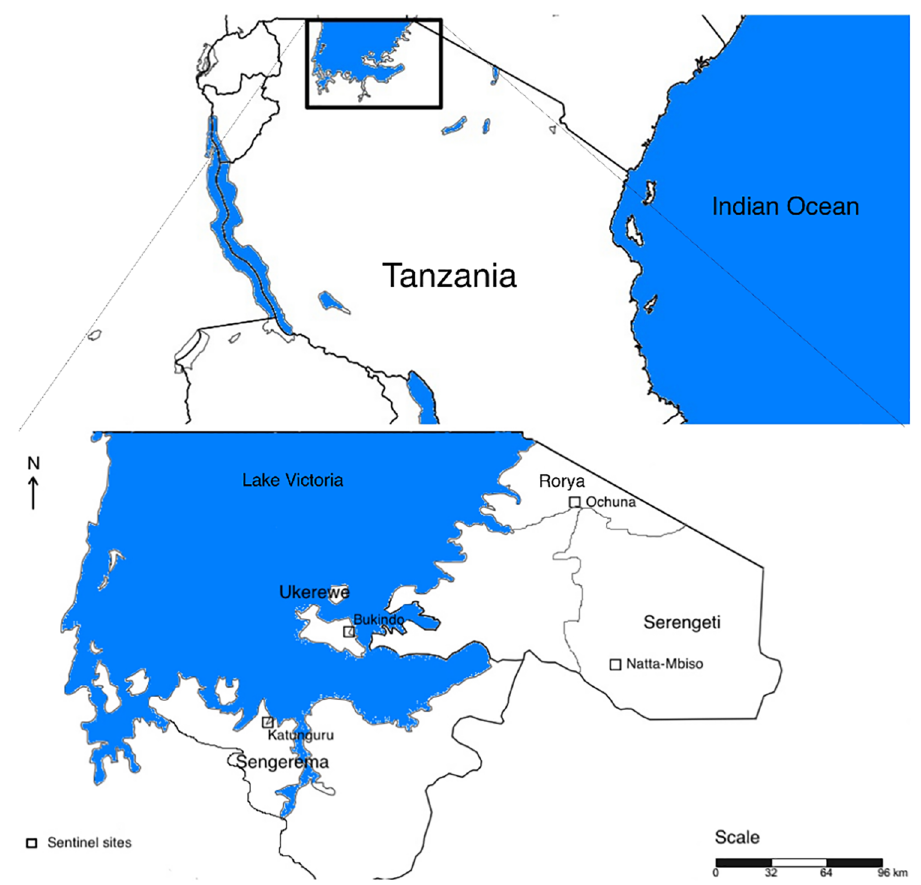
Fig 1. The map of Lake Victoria basin showing the sentinel sites under 2014 IRS campaigns. This map was obtainedby manual digitizing via public domainof the Geographic informationsystem (http://www.